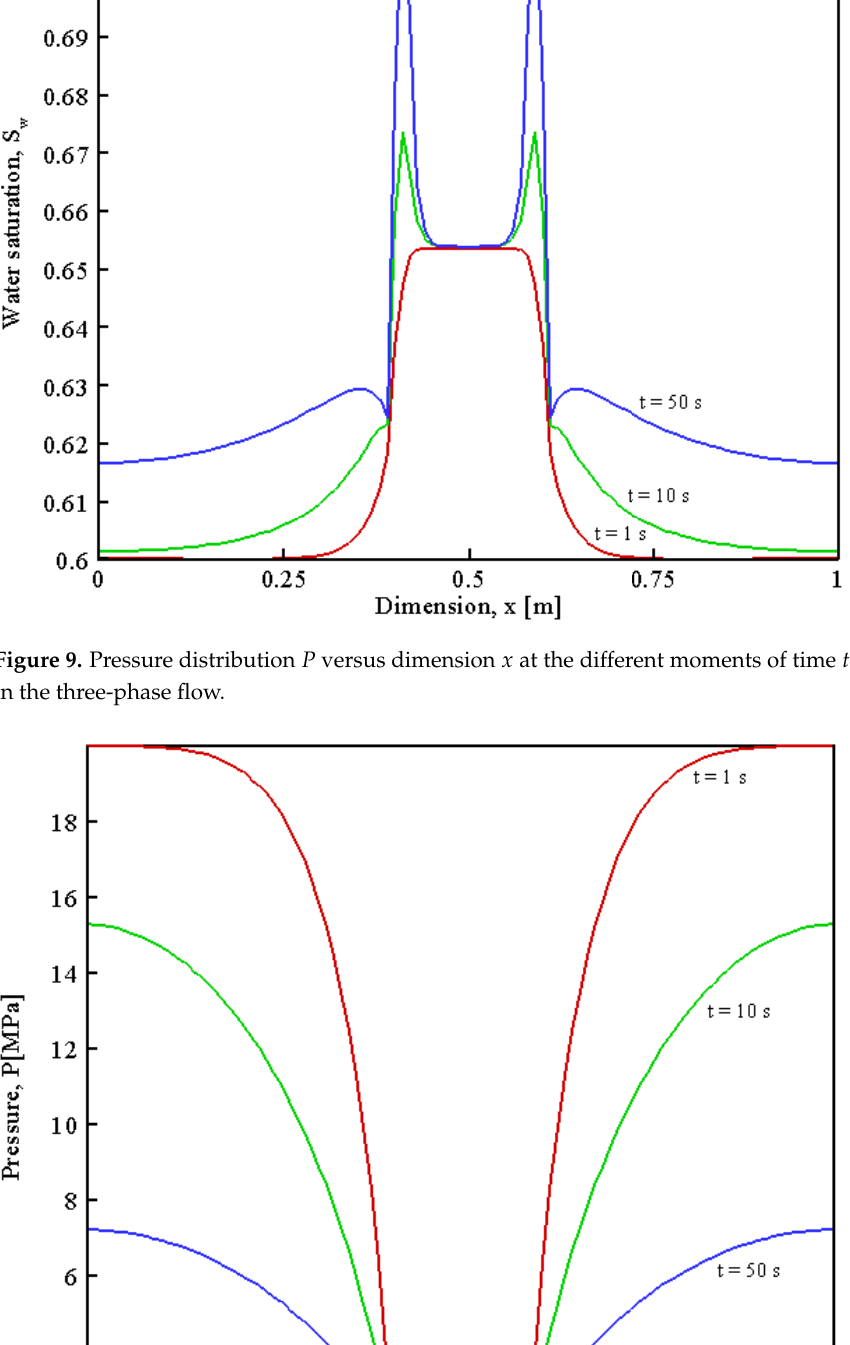
Figure 10. Temperature distribution T versus dimension x at the different moments of time t = 1, 10, 50s in the three-phase